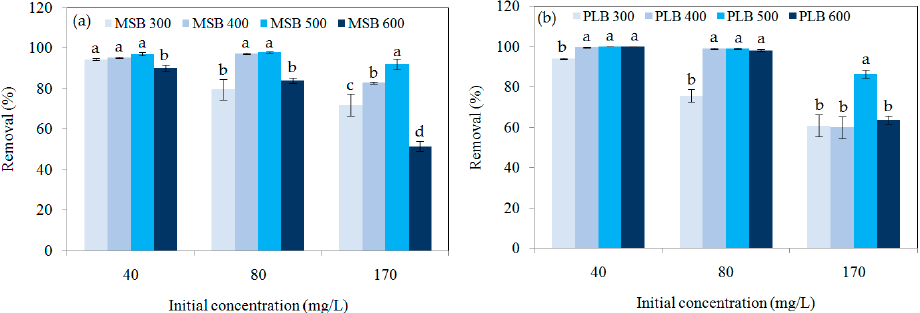
Figure 6. Comparisons of Cd removal by ( a ) MSB and ( b ) PLB from different pyrolytic